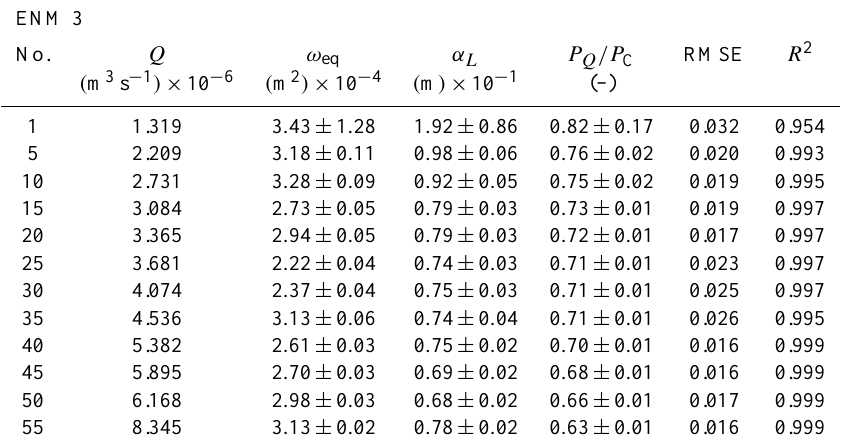
Table 3. Estimated values of parameters, RMSE, and determination coefficient r 2 for ENM3 at different injection flow rates in the fractured medium.